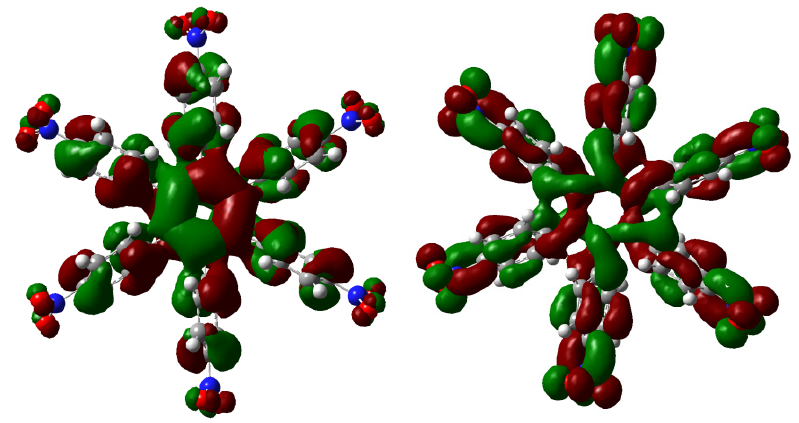
Figure 9. Frontier molecular orbitals for HAB4